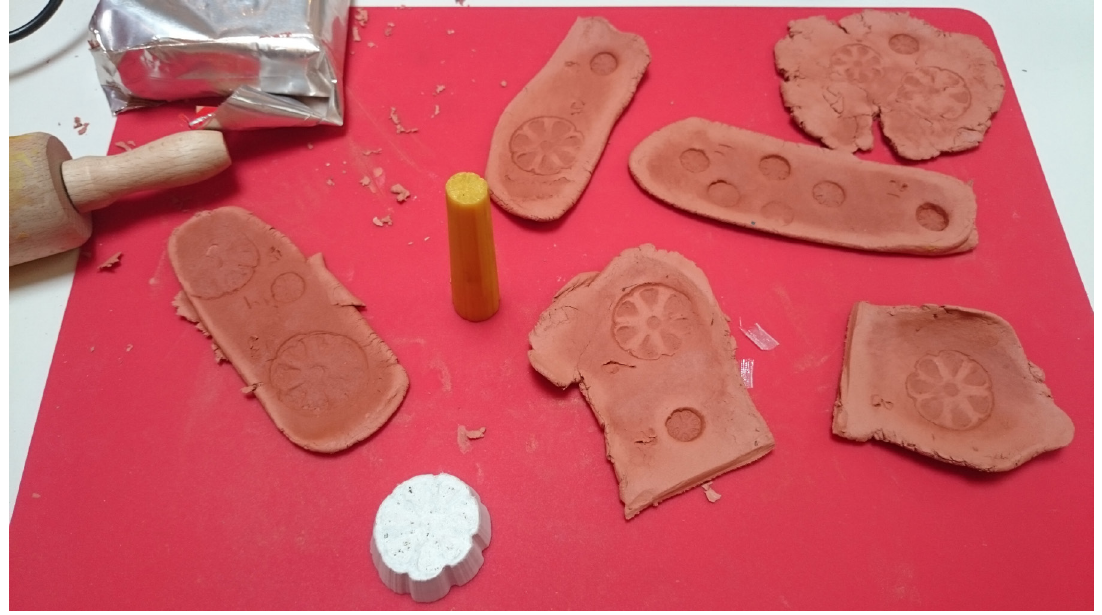
Figure 3. The 3D printed stamping tools and sheets of clay with stamp imprints of museum visitors. Photo by L.